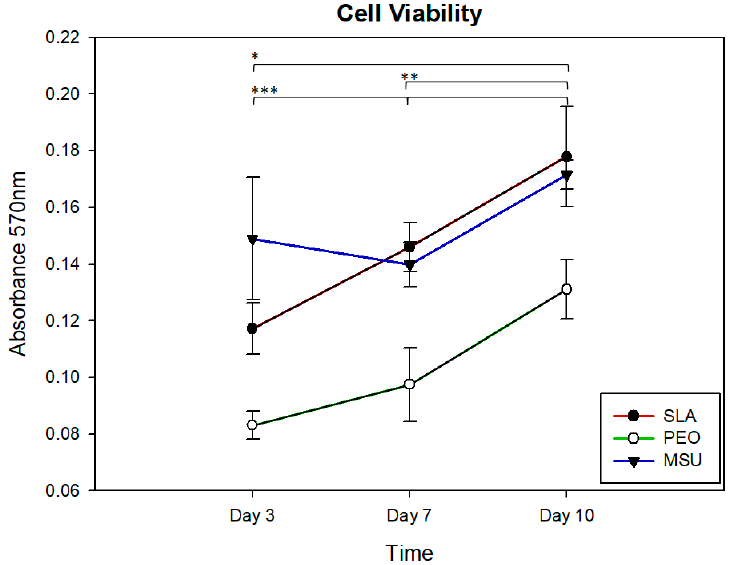
Figure 3. Cell growth and viability for SLA surface and PEO-treated surface under cell culture conditions at days 3, 7, and 10. SLA surface—* 3 to 7 days and from ** 7 to 10 days ( p < 0.05); PEO surface—*** 3 to 7 days ( p = 0.01) and from 7 to 10 days ( p < 0.05).